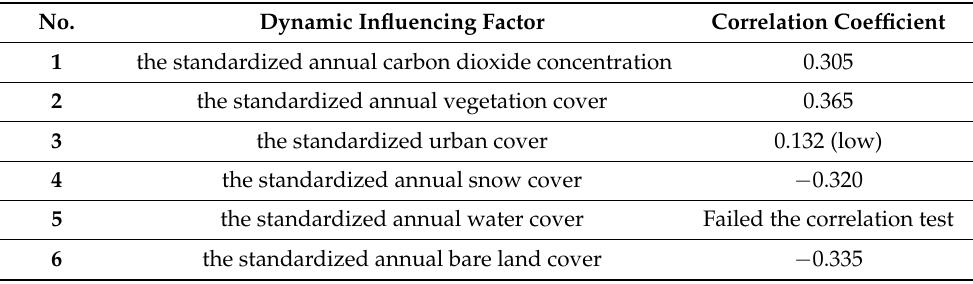
Table 2. Correlation coefficients between the standardized temperature change and dynamic influ- encing factors in annum.